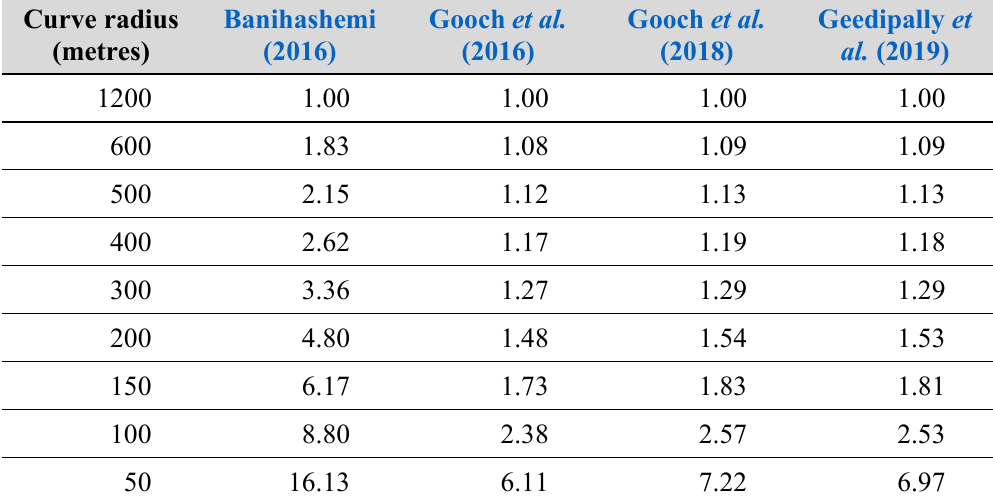
Table 1 Relative accident rate in curves as a function of radius — set to 1.00 for a radius